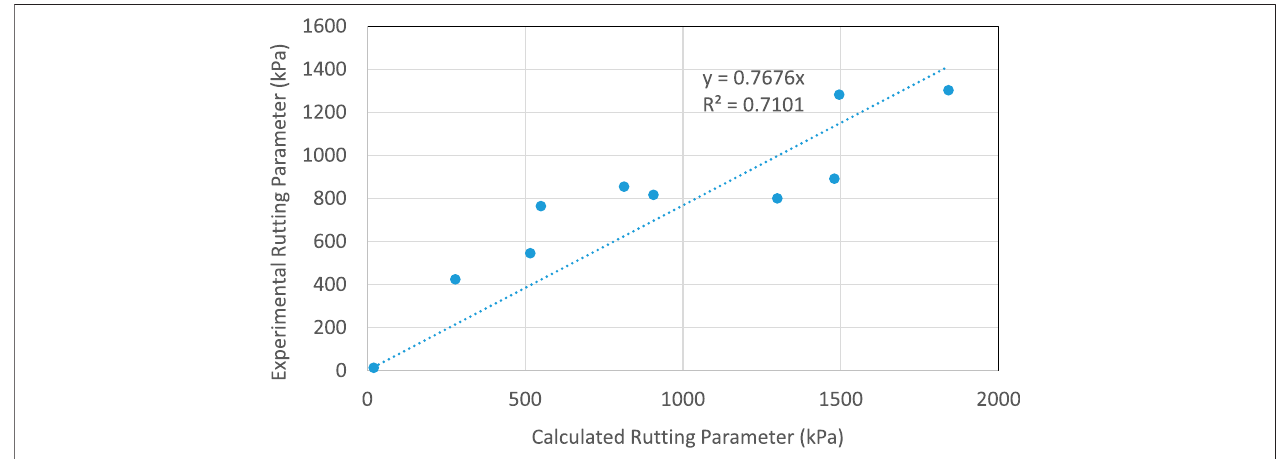
FIGURE 7 | Predicted vs. experimental rutting parameter for the unaged unmodi fi ed CMAs: Testing (validation) points.